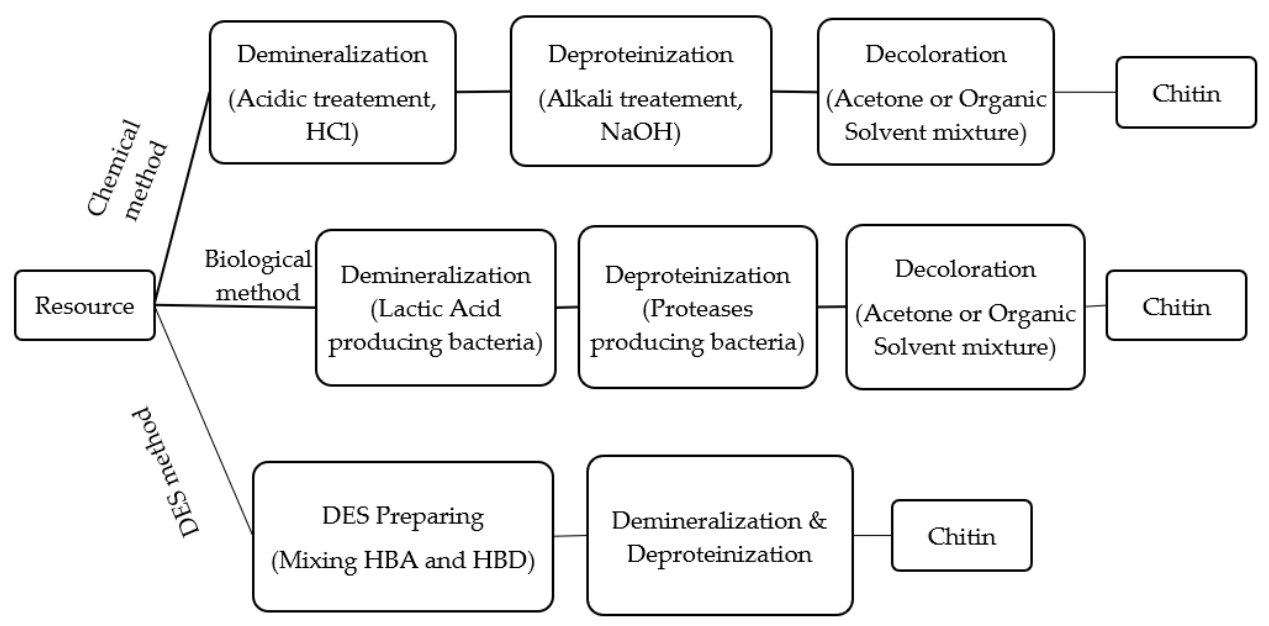
Figure 2. Extraction of chitin. DES: deep eutectic solvents; HBA: hydrogen bond acceptor; HBD: hydrogen bond donor.